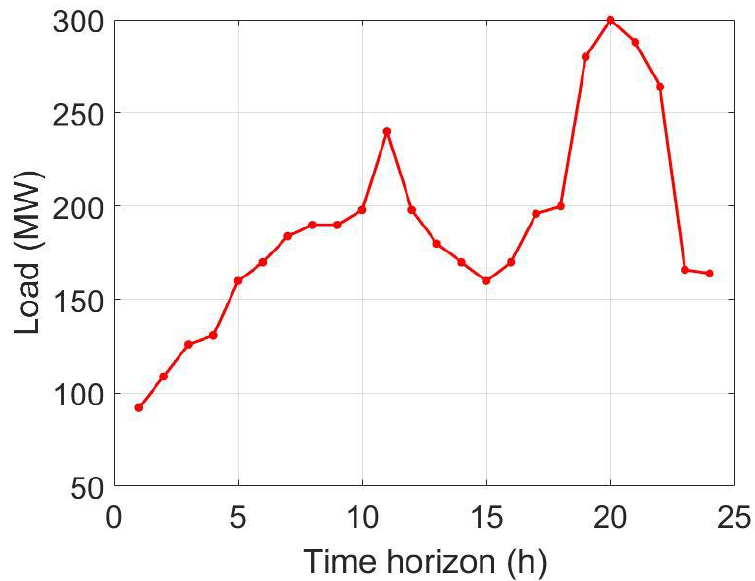
Figure 2. Load curve.